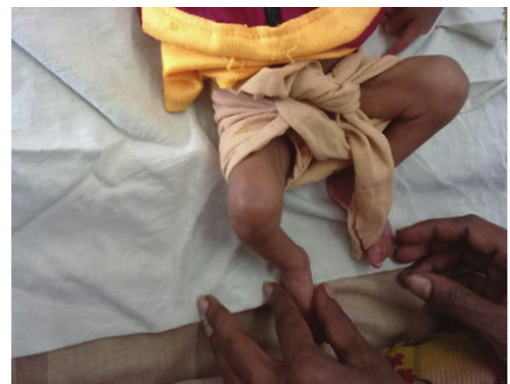
Figure 2: Swelling of right knee joint with no signs of inflamma- tion.